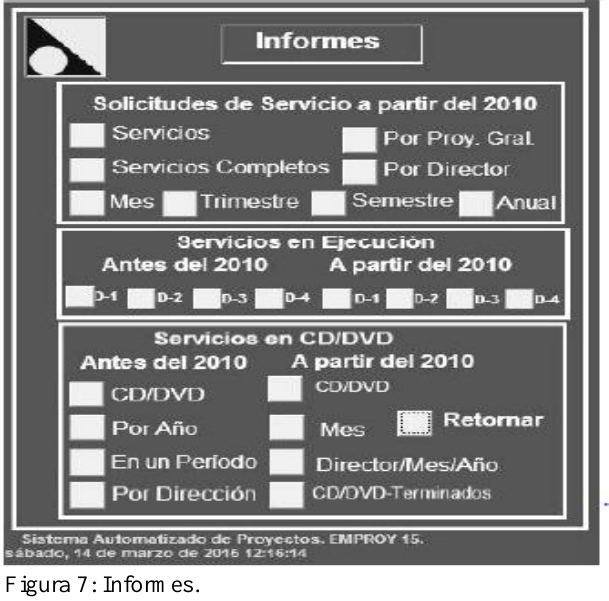
Figura 7: Informes. Fuente: Autor, (2018).